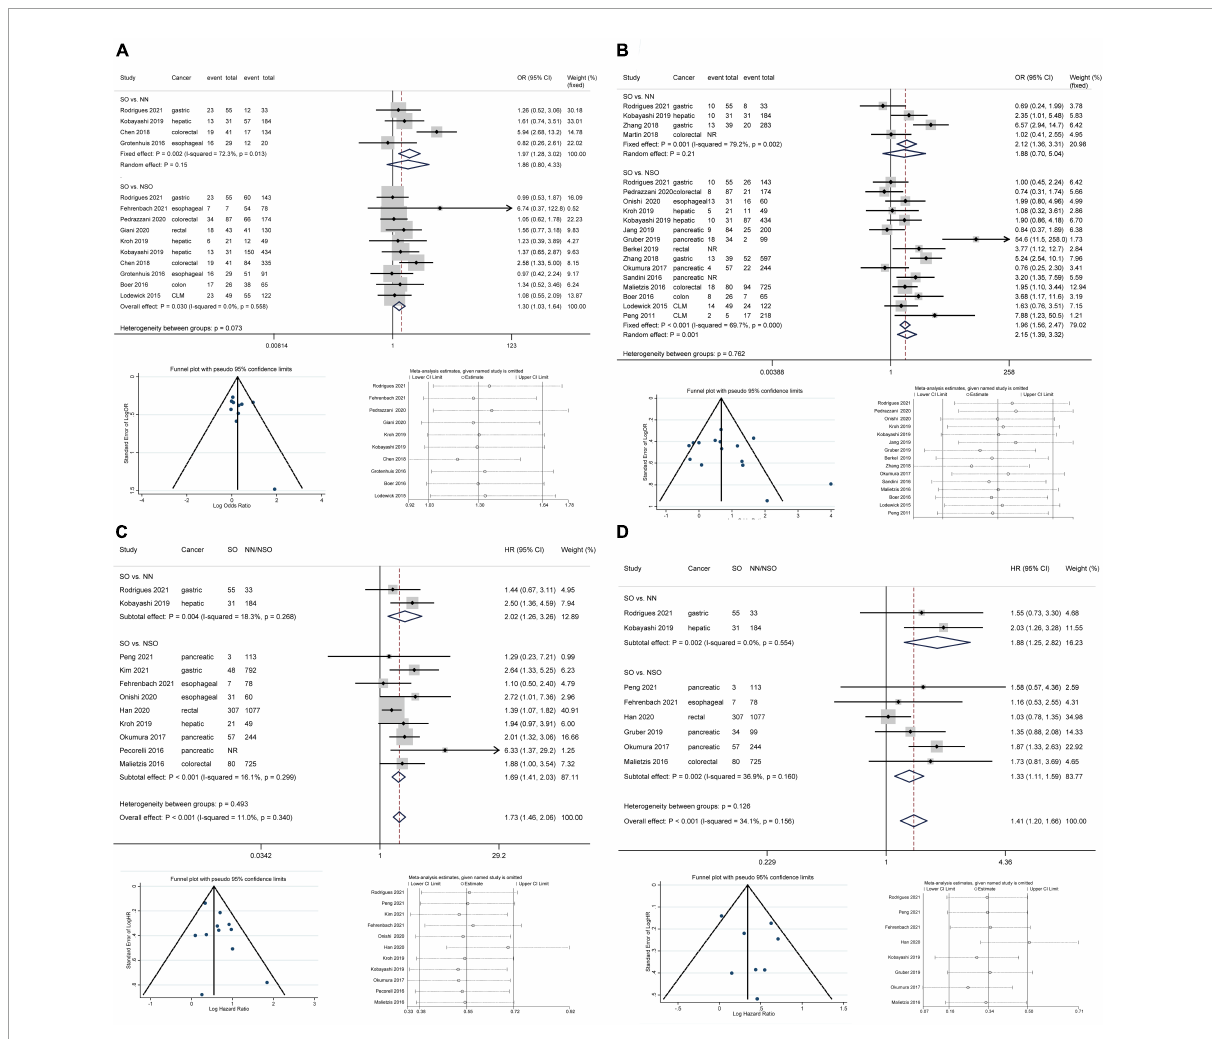
FIGURE2 Forest plots of meta-analyses for sarcopenic obesity and primary outcomes. The funnel plots and sensitivity analyses of SO vs. NSO are provided. (A) Total complications; (B) major complications; (C) overall survival; (D) disease-free survival. CI, confidence interval; CLM, colorectal liver metastasis; HR, hazard ratio; NN, non-sarcopenic non-obesity; NR, not reported; NSO, patients without sarcopenic obesity; OR, odds ratio; SO, sarcopenic